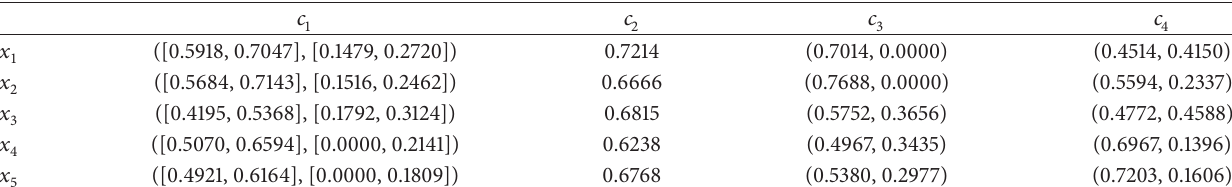
Table 7: Final evaluation information 𝑅 .